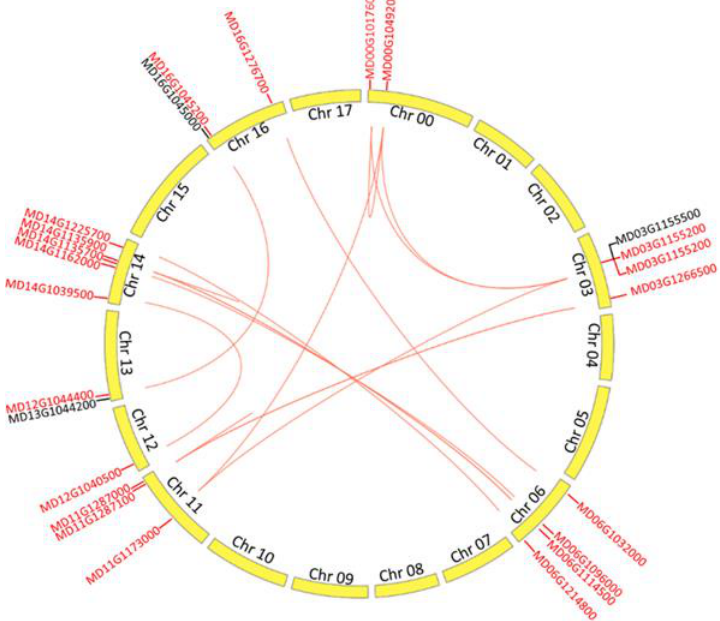
Figure 2. Chromosomal distribution and gene duplication of the MdALMT genes. Gene IDs are labeled on the basis of their position on the chromosomes. The red line represents the putative whole-genome-duplication (WGD)/segmental-duplication genes or tandem-duplication genes.